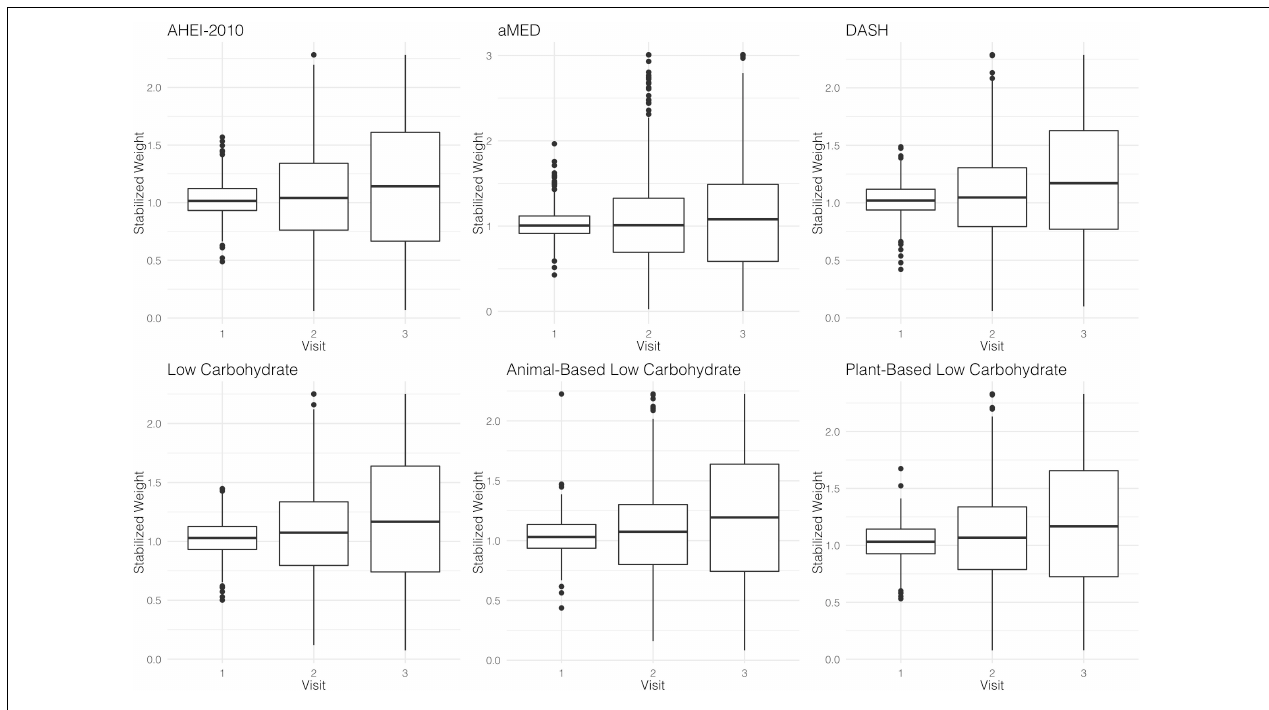
FIGURE 2 | Distributions of diet quality index-specific weights at each study visit.